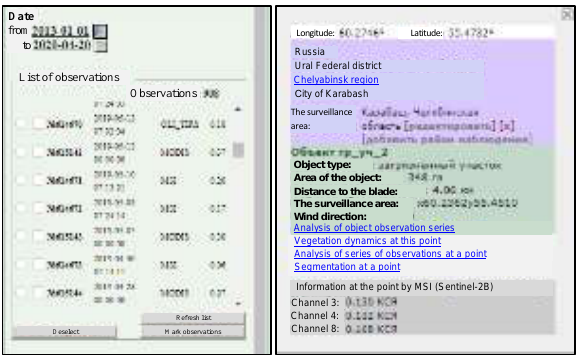
Figure 2. General functional scheme of TWDS SRMV